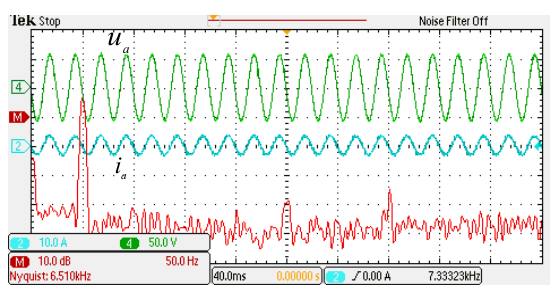
Figure 17. The experimental waveforms of the grid current and the corresponding FFT analysis for the proposed scheme at 10 kHz switching frequency.